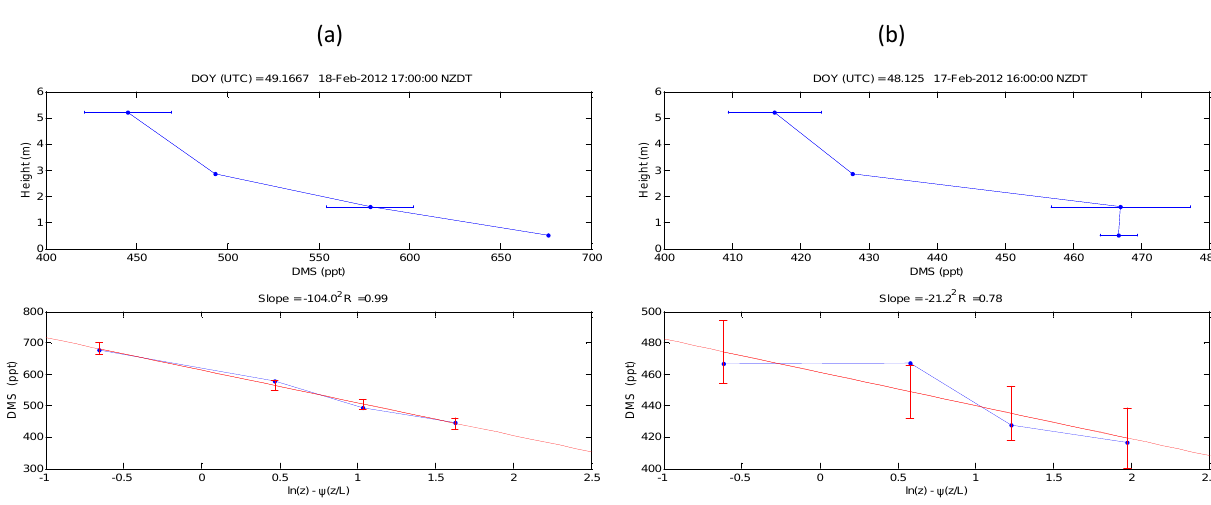
Figure 4. Examples of DMS gradients: (a) good-quality data, (b) poorer quality. The upper plots show the decrease in DMS concentration away from the sea surface. Error bars are the standard deviation of multiple samples. The lower plots show the concentration decrease against the log of stability adjusted height, as described in Eq. (3), with the least squares fit of the log profile shown in red. Error bars are calculated from the residual error of the